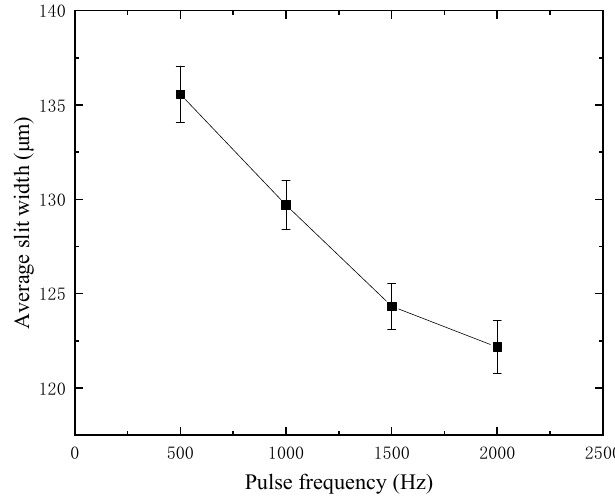
Figure 13. Slit width at different pulse frequencies.